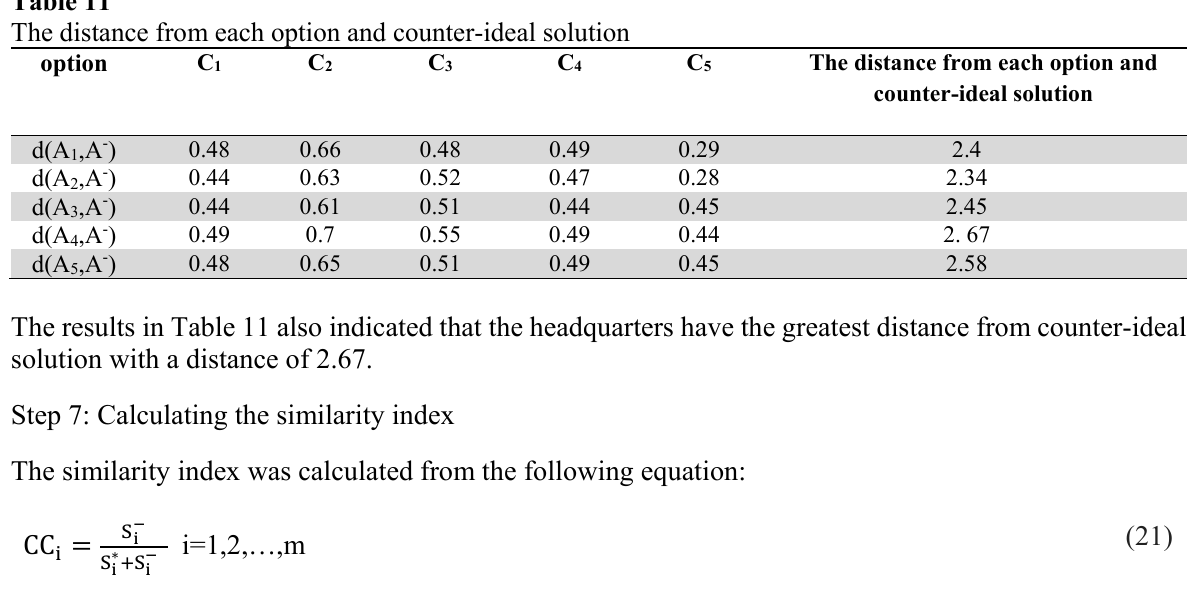
counter-ideal solution